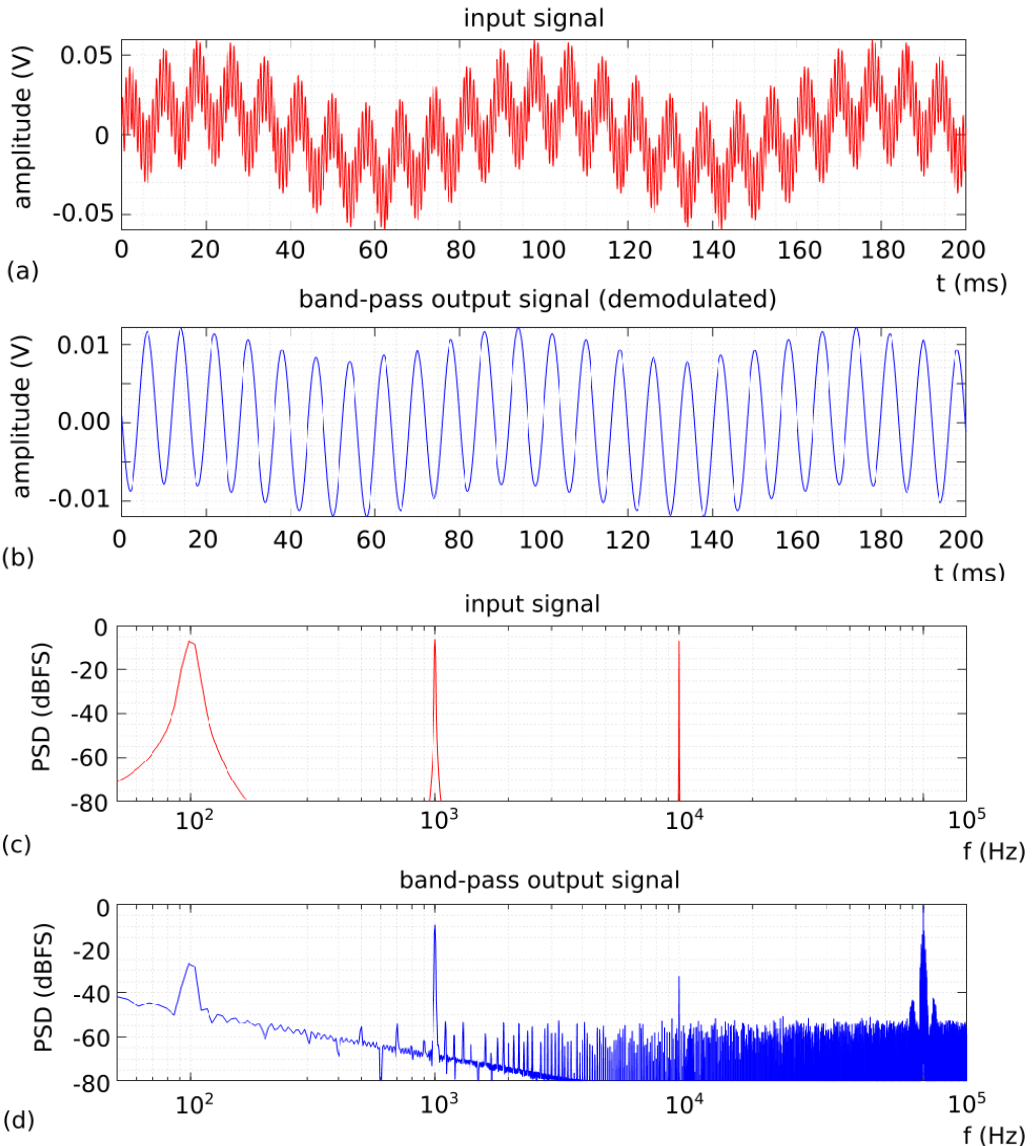
Figure 4. Behavioral simulation of the proposed VCO-based bi-quad filter: ( a ) input signal in time; ( b ) demodulated output signal in time; ( c ) input signal spectrum; and ( d ) output signal